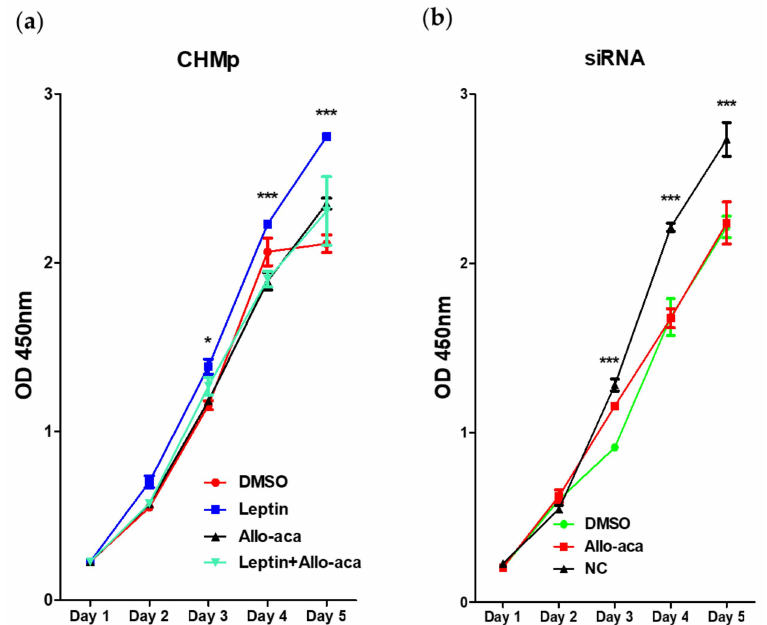
Figure 2. Cellproliferationassay. Quantitativemeasurementwasdeterminedby3-(4,5-dimethylthiazol-2-yl)- 2,5-diphenyltetrazolium bromide (MTT) assay. Five thousand cells per well were seeded and cultured for 5 days in a 37 ◦ C, 5% CO 2 incubator. ( a ) Leptin significantly promoted cancer cell proliferation from day